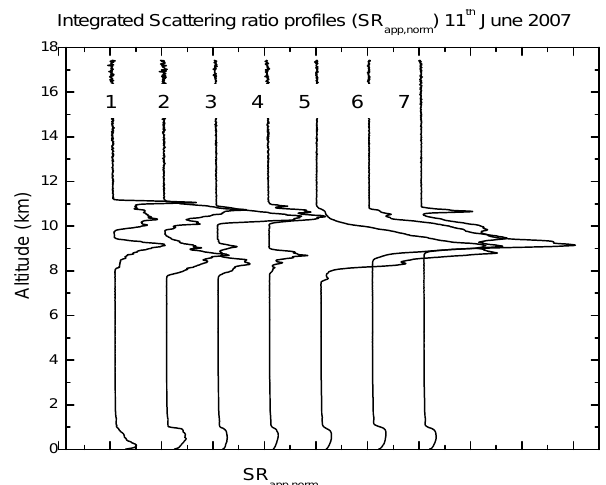
Fig. 6. Integrated scattering ratio (SR app,norm ) profiles on 11 June 2007 corresponding to the respective stationary periods, determined by applying the statistical method suggested by Lanzante (1996). Is this case, seven independent profiles of SR were